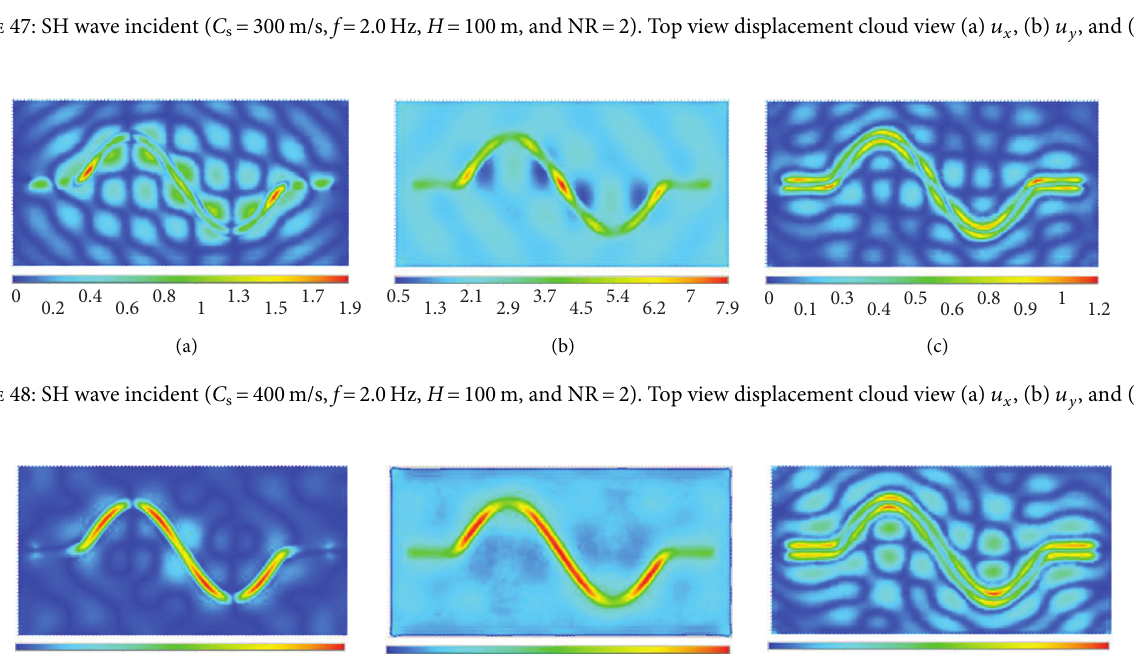
u u x , (b) y , and (c) z .